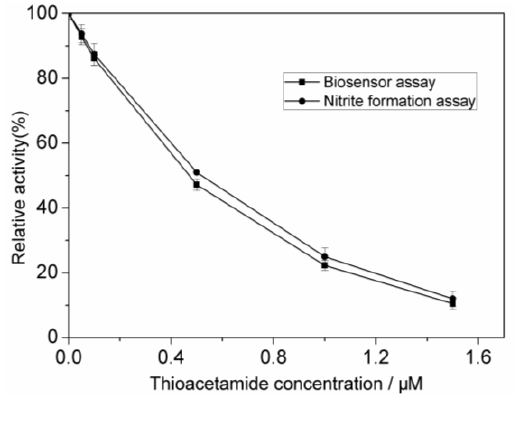
Figure 6. Inhibitory curves of thioacetamide at different concentrations obtained by the present biosensor (■) and the colorimetric nitrite formation assay (●) (relative activity% = 100%-inhibition%). Each error bar represents one standard deviation for three